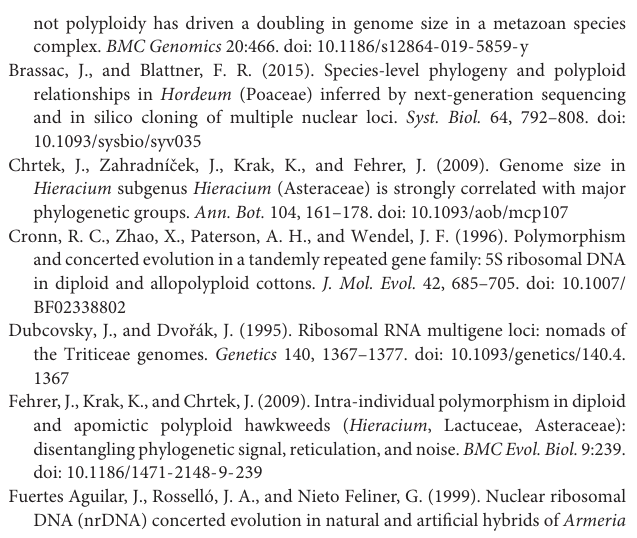
Supplementary Figure 1 | Correlation between copy numbers of native ribotype estimated using qPCR and Illumina read mapping. Supplementary Figure 2 | Correlation between the DNA extraction efficiency (expressed as DNA extract concentration) and the copy number of nrDNA, for both native (A) and foreign (B) ribotypes. Supplementary Figure 3 | Molecular cytogenetic analysis of Hordeum species. Fluorescent signal of 45S-rDNA (labeled with biotin, arrows) has been observed after FISH on one or two pairs of chromosomes of H. bogdanii BCC2063 (A) , H. bulbosum GRA970 (B) , H. californicum BCC2057 (C) , H. cordobens e BCC2067 (D) , H. erectofolium BCC2026 (E) , H. euclaston BCC2022 (F) , H. flexuosum BCC2023 (G) , H. intercedens BCC2044 (H) , and H. marinum BCC2001 (I) . In H . cordobense (D) and H. erectifolium (E) , minor loci of 45S-rDNA on one pair of chromosomes have been observed (arrowheads). Hordeum bulbosum GRA970 is tetraploid (2 n = 28), hence it was excluded from qPCR analyses. Scale bar 10 µ m. Supplementary Figure 4 | Molecular cytogenetic analysis of Hordeum species. Fluorescent signal of 45S-rDNA (labeled with biotin, arrows) has been observed after FISH on one or two pairs of chromosomes of H. murinum BCC2002 (A) , H. murinum BCC2017 (B) , H. muticum BCC2042 (C) , H. patagonicum subsp. setifolium BCC2032 (D) , H. pubiflorum BCC2028 (E) , H. pusillum BCC2049 (F) , H. roshevitzii BCC2015 (G) , H. stenostachys BCC2041 (H) , and H. vulgare cv. Morex (I) . In H. murinum BCC2017 (B) and H. vulgare cv. Morex (I) , minor loci of 45S-rDNA on one pair of chromosomes have been observed (arrowheads). Scale bar 10 µ m. Supplementary Figure 5 | (A) Correlation between the genome size (2C value) and the copy number of native ribotype, (B) correlation between the number of nrDNA loci and the copy number of native ribotype. Supplementary Figure 6 | Correlations between the copy numbers of native and foreign ribotypes. (A) Setaria -like ribotype; (B) Paspalum -like ribotype; (C) Panicum -like ribotype; (D) Euclasta -like ribotype. Supplementary Table 1 | Characteristics of Hordeum samples used in the study. Supplementary Table 2 | Detailed description of the qPCR assays used to quantify nrDNA in Hordeum . Supplementary Table 3 | Comparison of copy numbers of native ribotype estimated using qPCR and Illumina read